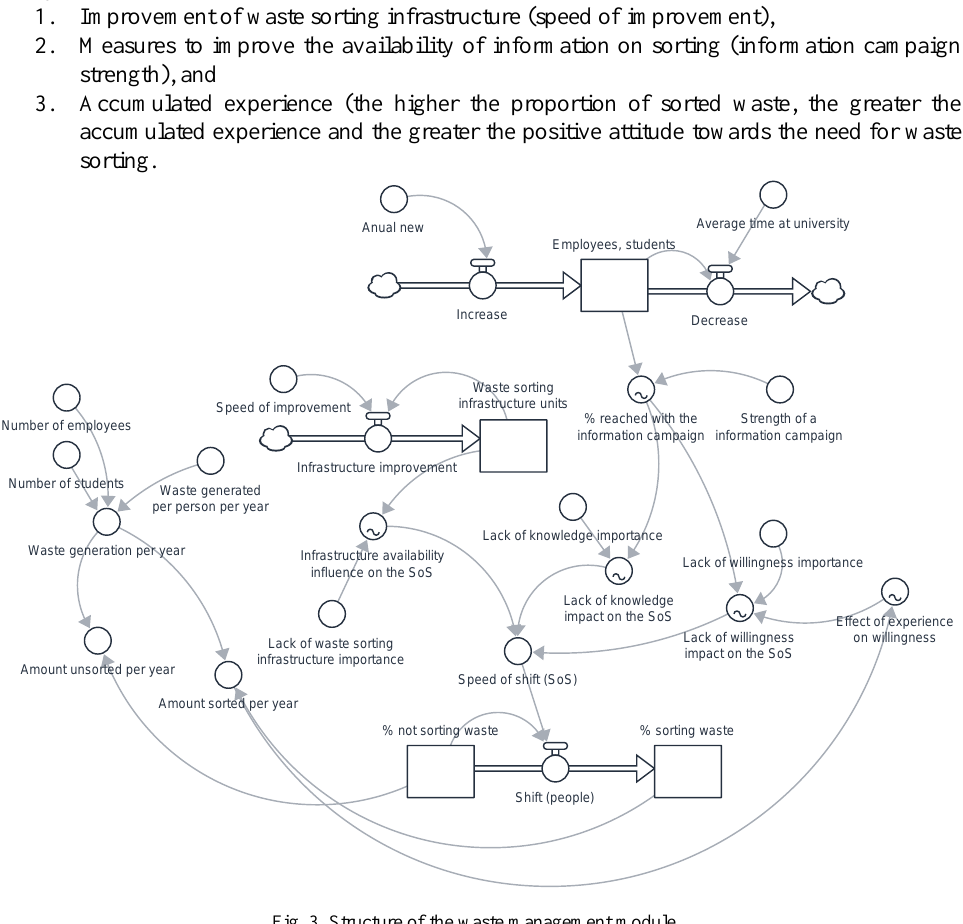
ff e c t (cid:9) o f (cid:9) e x pe r i en c e on (cid:9) w illi ngne